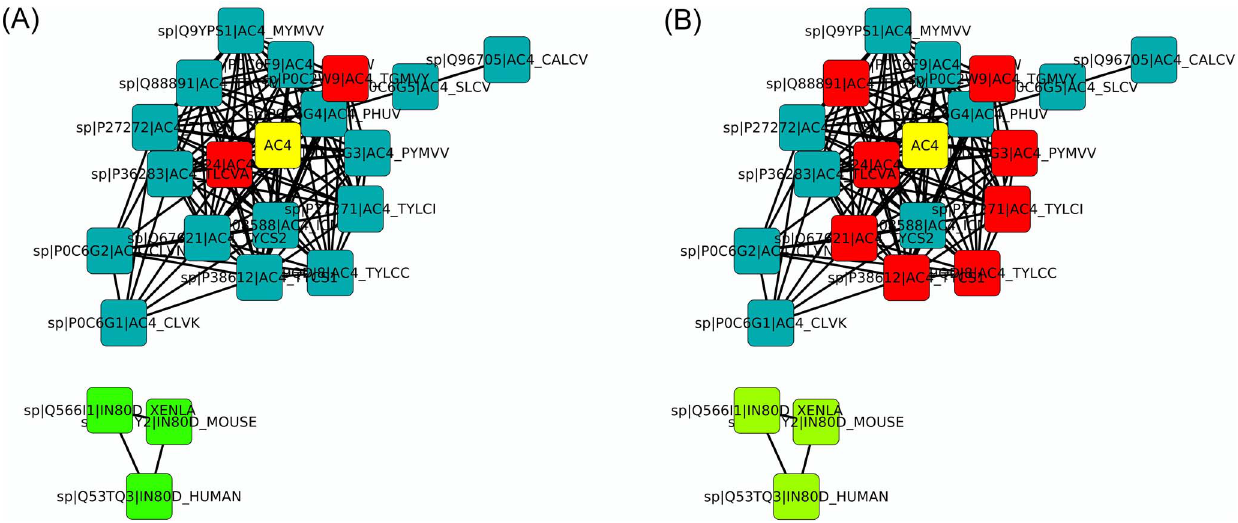
Figure 3. PANADA results of a sequence with no functional annotation. Starting from the viral protein AC4 (UniProt accession number P0DJX3), the constructed network is shown in Cytoscape with organic layout. (A) is colored by biological process with red for ‘‘virus-host interaction’’ (IEA) and green for ‘‘DNA recombination; DNA repair; regulation of transcription, DNA-dependent’’ (IEA). (B) is colored by cellular component with red for ‘‘host cell plasma membrane’’ (IEA) and green for ‘‘nucleus’’ (IEA). In both cases, the yellow color is used for the query protein AC4.